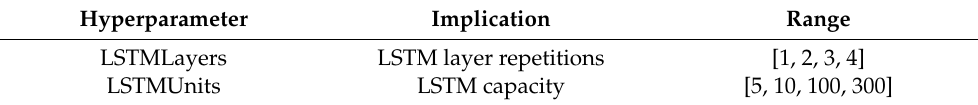
Table 2. Hyperparameter grid search for LSTMs.